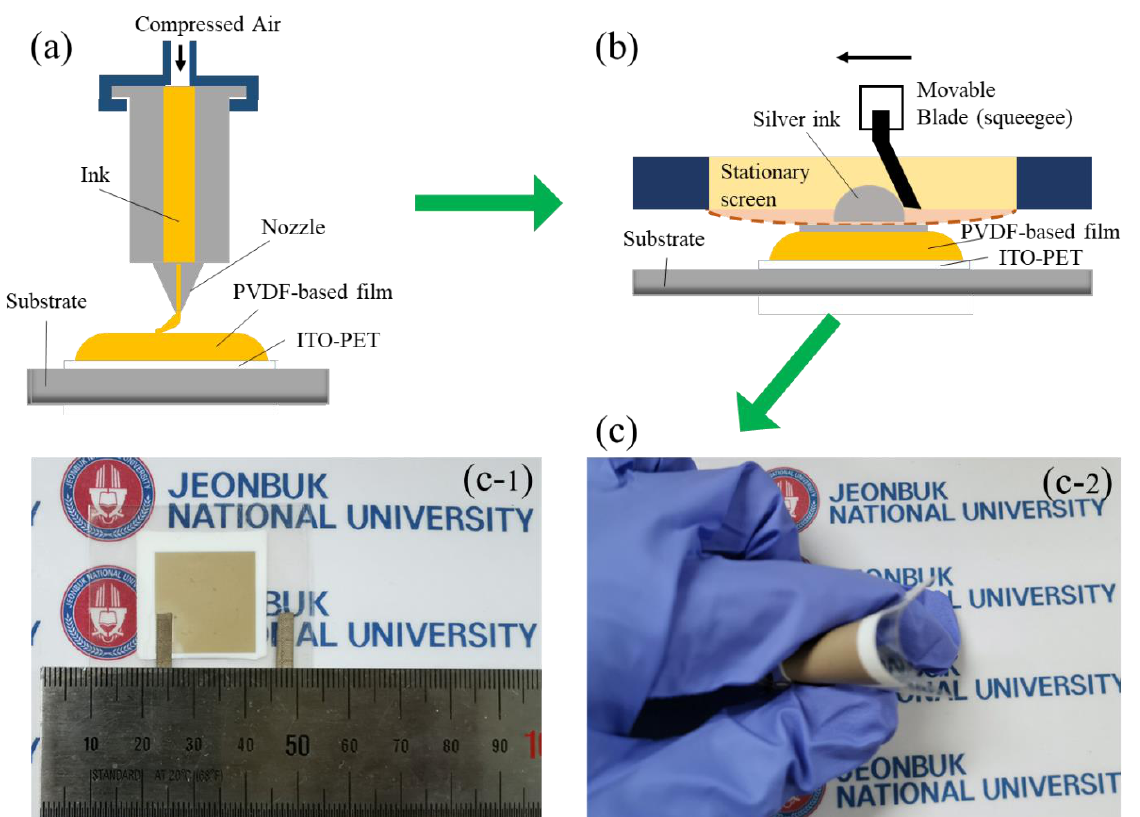
Figure 1. Schematic illustration of ( a ) 3D printing process for PVDF-based film, ( b ) screen-printing process and ( c ) the optical images of the fully printed piezoelectric nanogenerators ( c-1 and c-2 show actual size of the all-printed device and its flexibility).